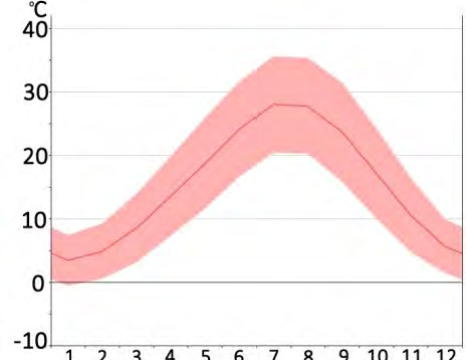
Figure 2. (b): Monthly Temperature Averages Of Gaziantep (Gaziantep,